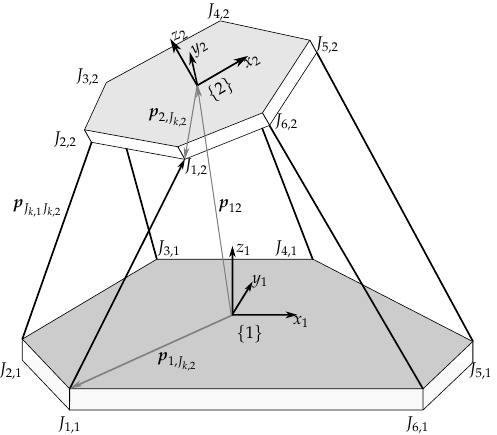
Figure 3. General assembly and nomenclature of the Stewart–Gough platform.